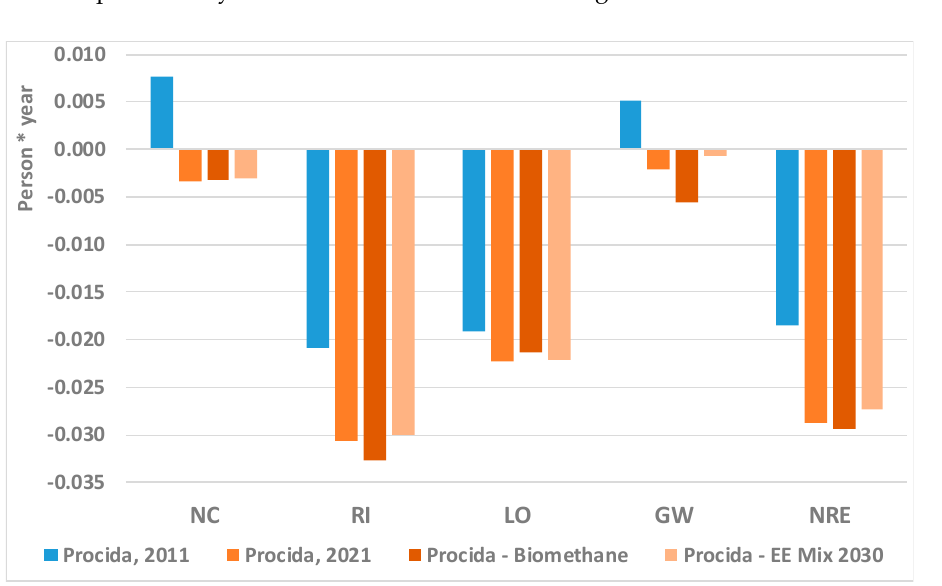
Figure 6. Results of sensitivity analysis scenarios, compared with those of base case scenarios. Results refer to the chosen functional unit (“the treatment of 1 tonne of MSW”) and are normalised in “person * year” (the average impact in a specific category caused by a person during one year in Europe). NC = non-carcinogens; RI = respiratory inorganics; LO = land occupation; GW = global warming; NRE = non-renewable energy.